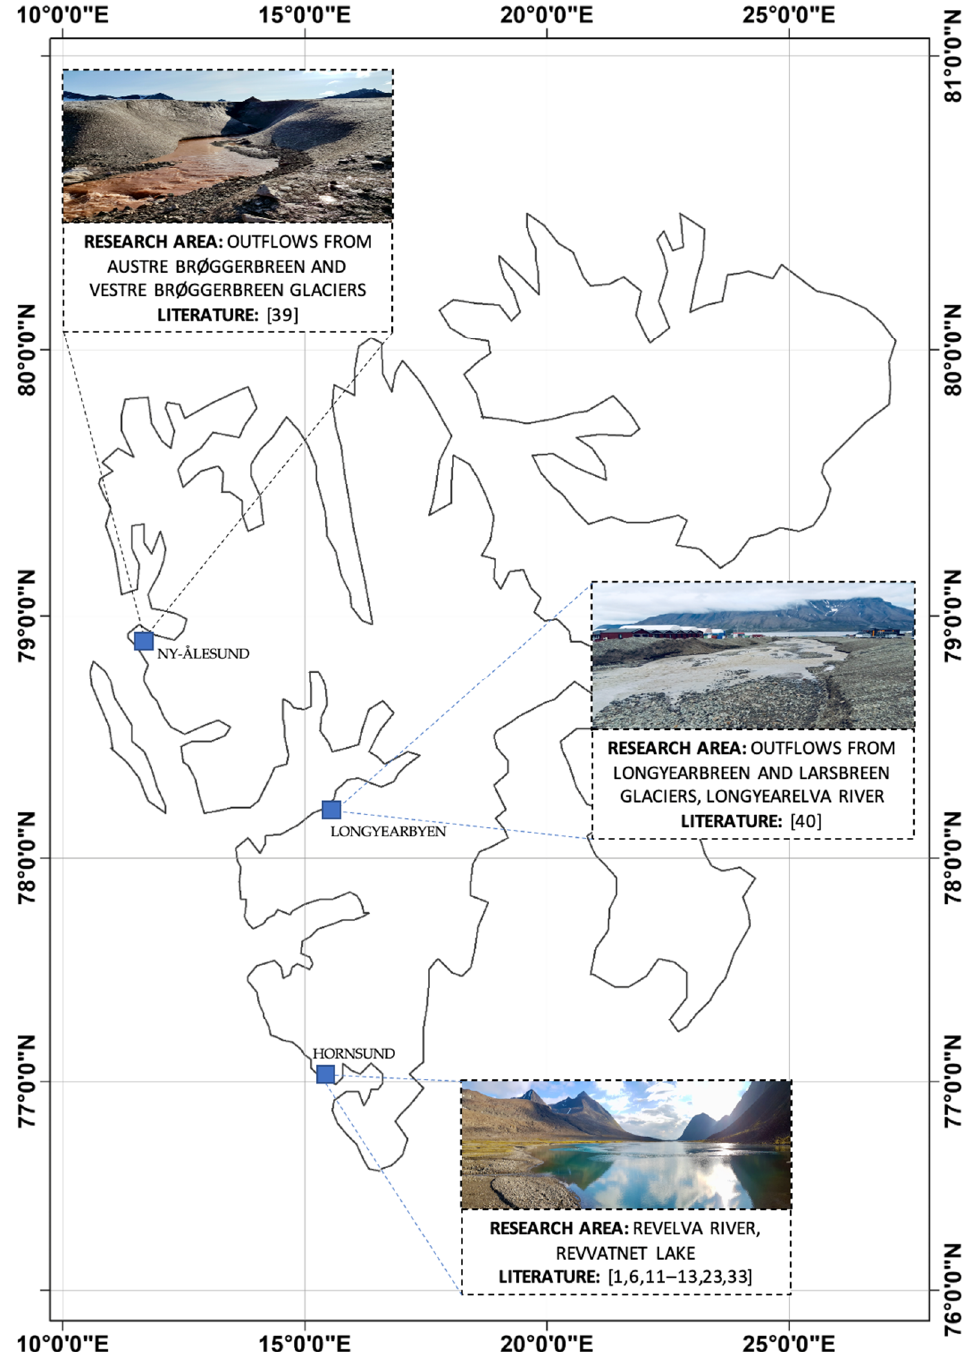
Figure 3. Location of areas where the authors of this review article have been conducting their research on POPs (mainly PAHs concentrations in freshwater). All photographs appearing in the article come from the authors’ private archive.